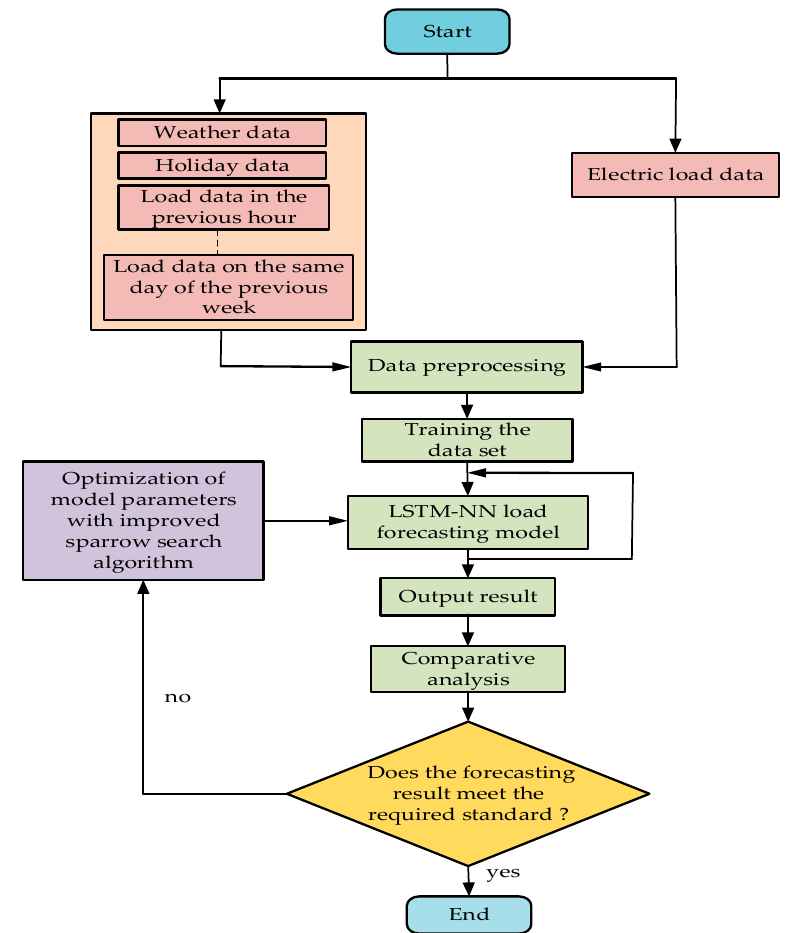
Figure 1. The flow chart of ILSTM-NN for load forecasting.